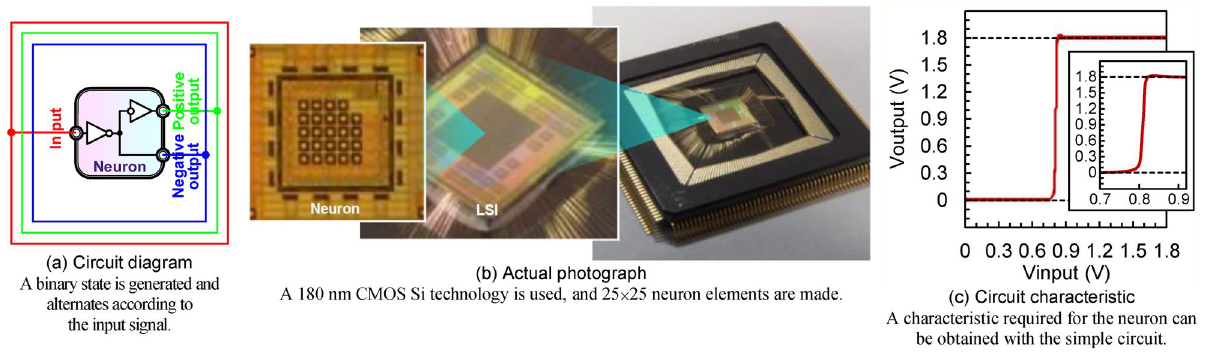
Figure 1. Neuron elements made in an